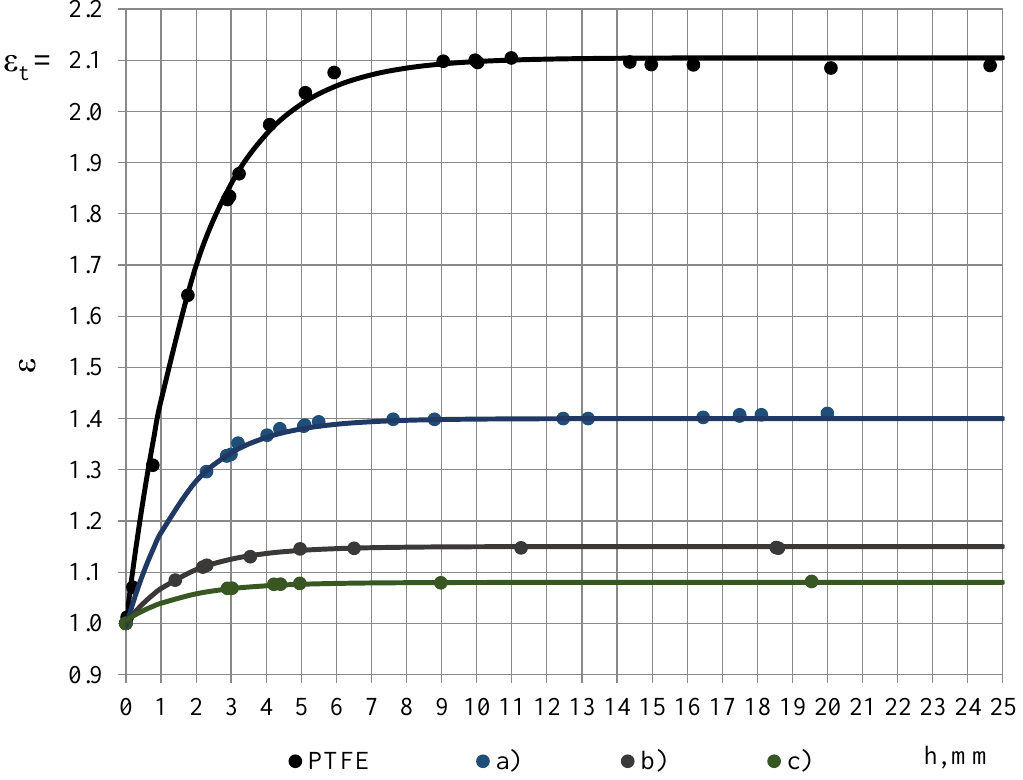
Figure 3. Measured value of permittivity in dependence of sample’s thickness: PTFE and lab-made PUR foams, density (a) 228, (b) 88 and (c) 50 kg/m 3 (experimental data and model functions, 1 kHz).